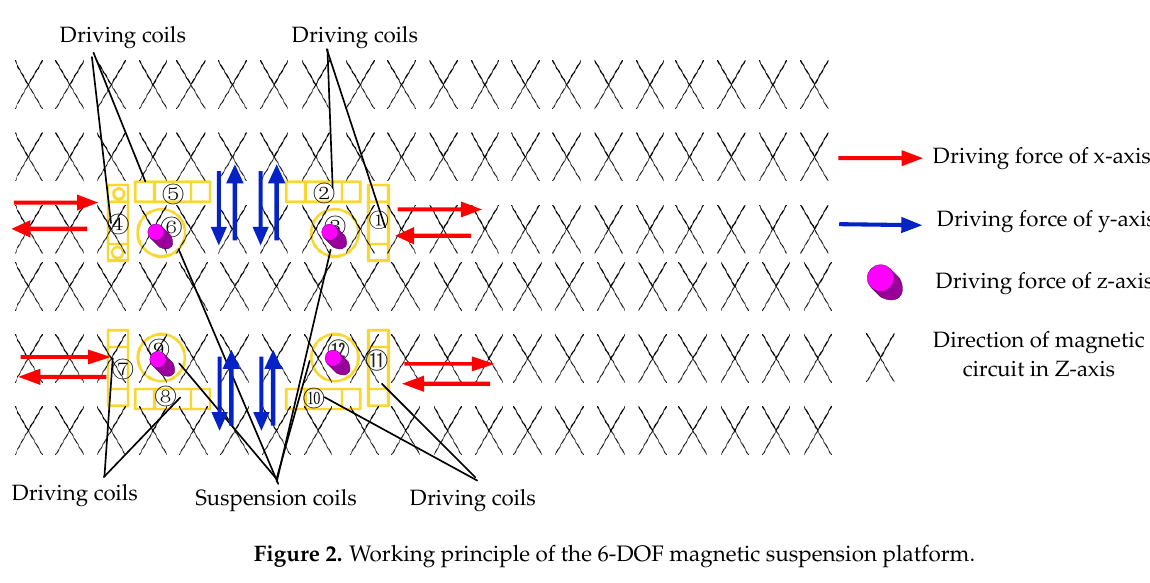
Figure 3. Structure of the 6-DOF magnetic suspension platform’s actuator.